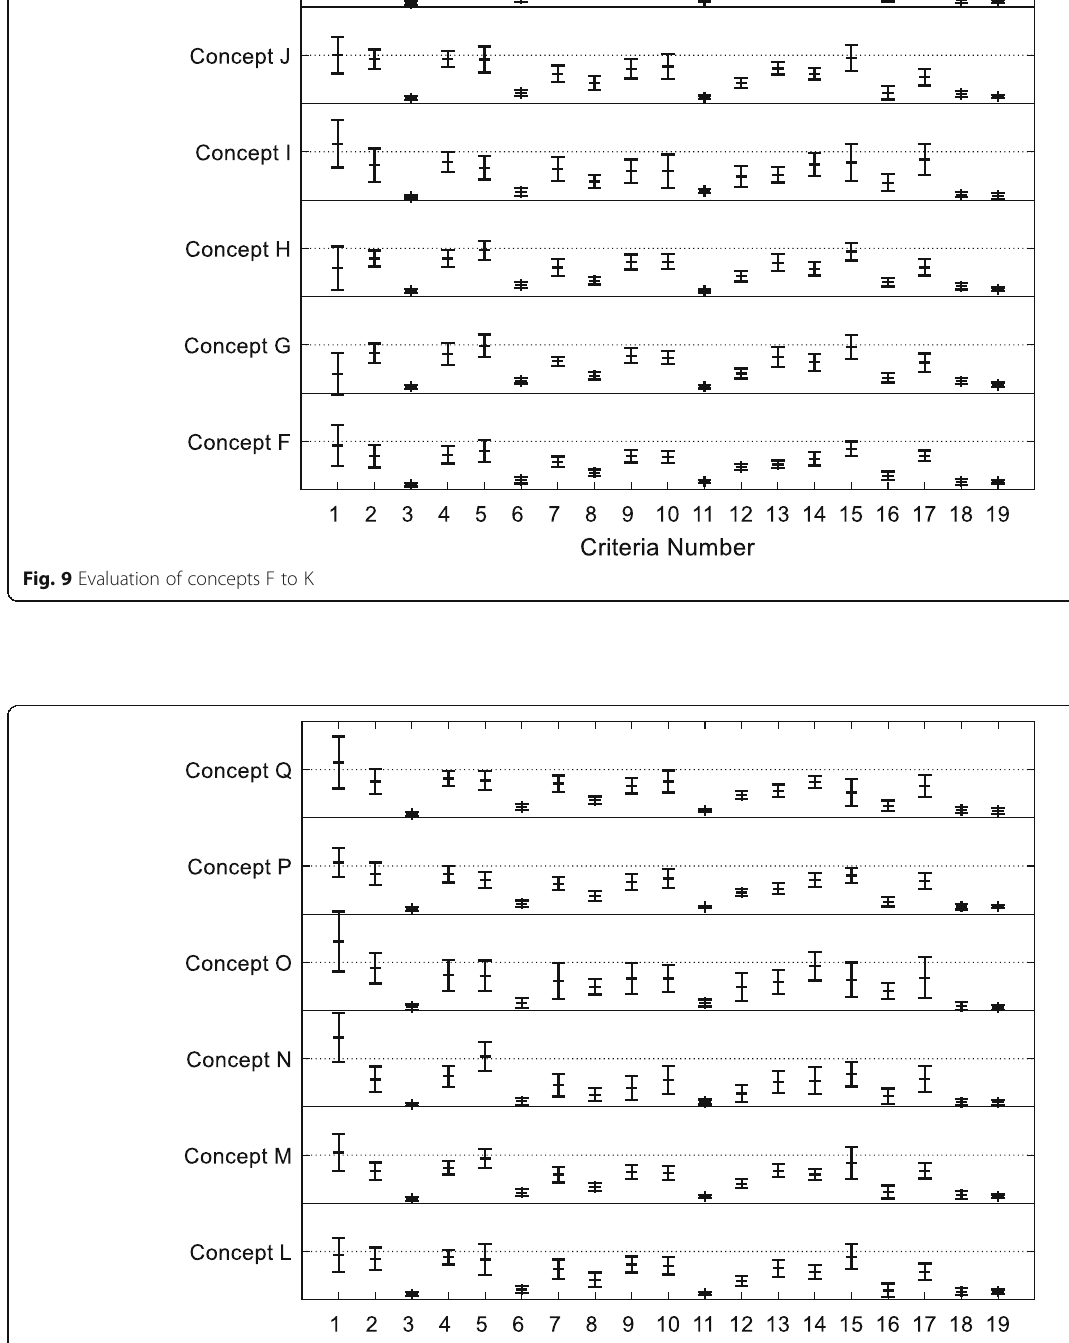
Fig. 10 Evaluation of concepts L to